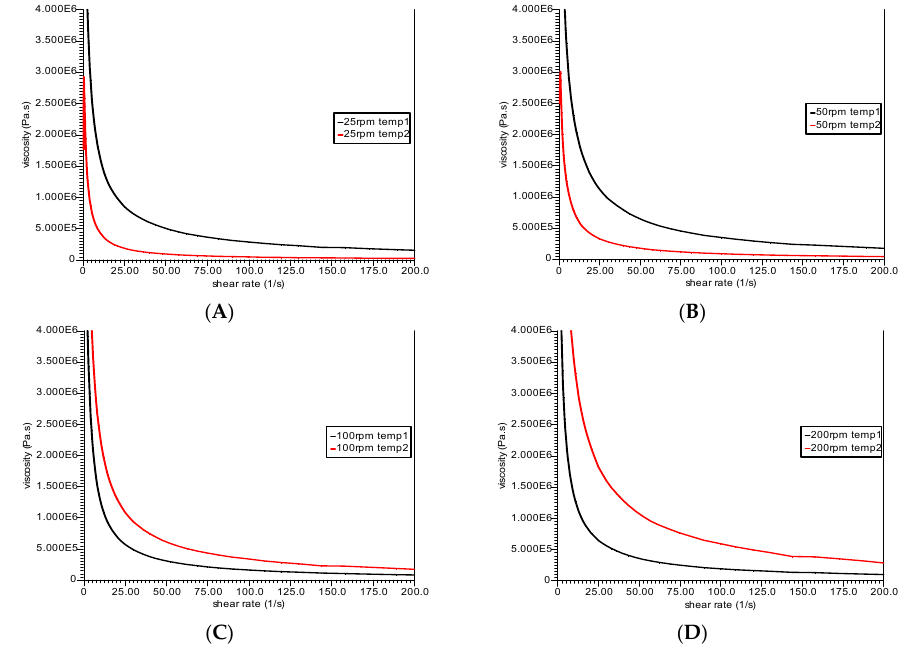
Figure 10. Viscosity ( η ) versus shear rate of Shellac samples produced by different temperature profiles and screw speeds: ( A ) 25 rpm; ( B ) 50 rpm; ( C ) 100 rpm and ( D ) 200 rpm.